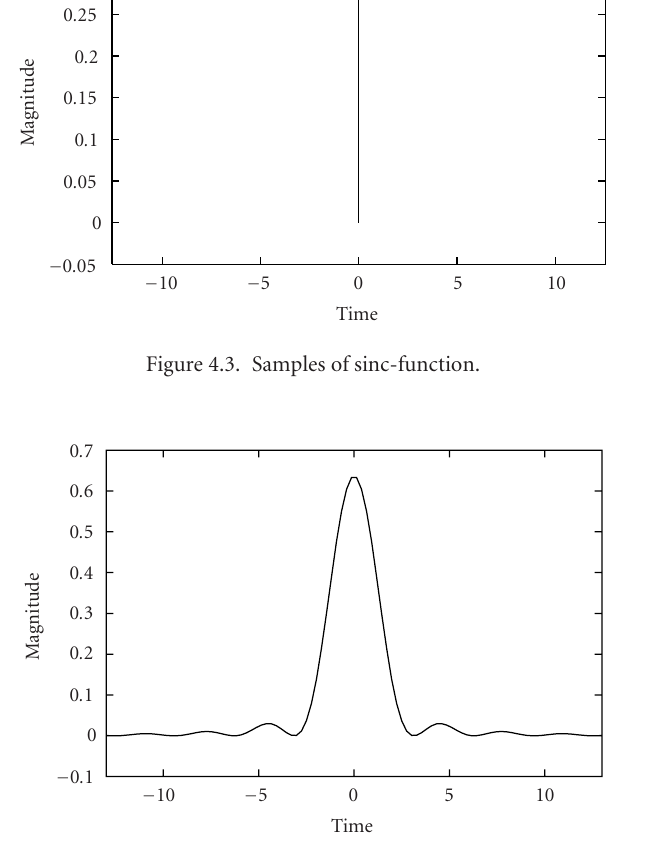
Figure 4.4. sinc-square